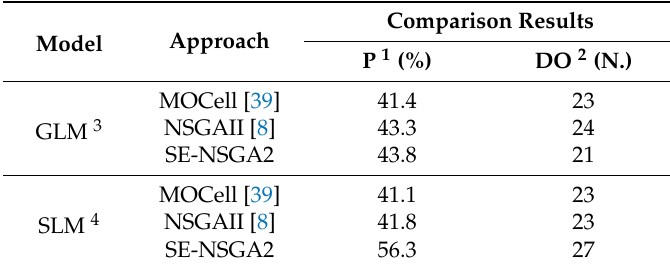
Table 8. Statistical results with compared